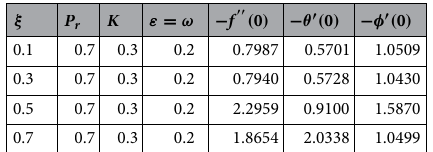
Table 1. Numerical values of skin friction coefficients for various values of ξ